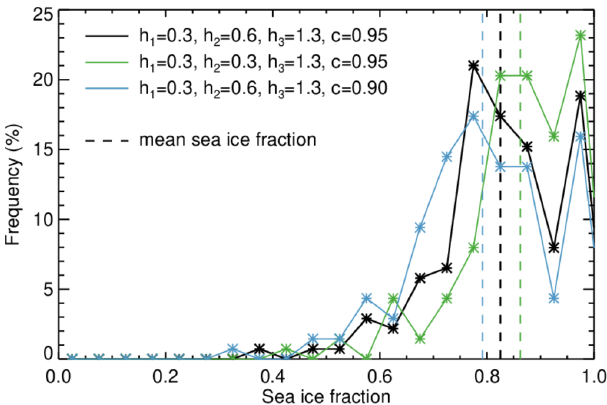
Figure 5. Frequency distribution of the sea ice fraction resulting from the applied sea ice mask for all images taken within the 20min time interval (black) and for adapted sea ice masks (color-coded). The vertical dashed lines represent the resulting mean sea ice frac-